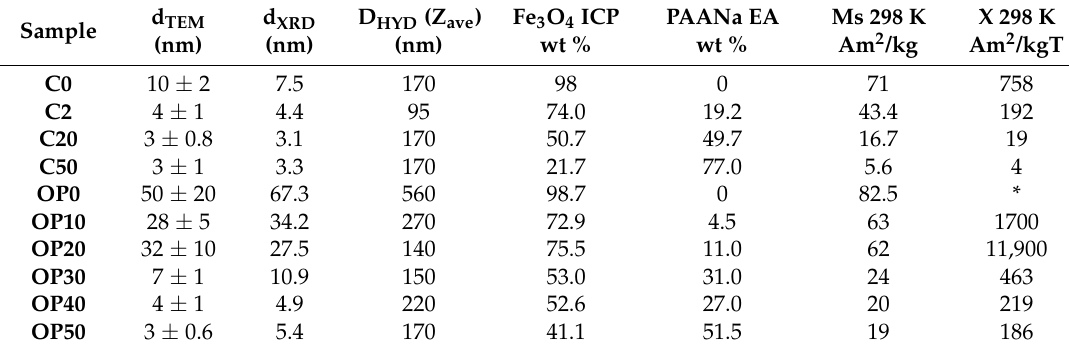
Table 1. Results of the characterization of the MNCs obtained by coprecipitation and oxidative precipitation in one step (d TEM = mean diameter by TEM; d XRD = mean crystal size by XRD; D HYD = hydrodynamic size in intensity (Z ave ) by DLS; Ms = saturation magnetization; χ = initial magnetic